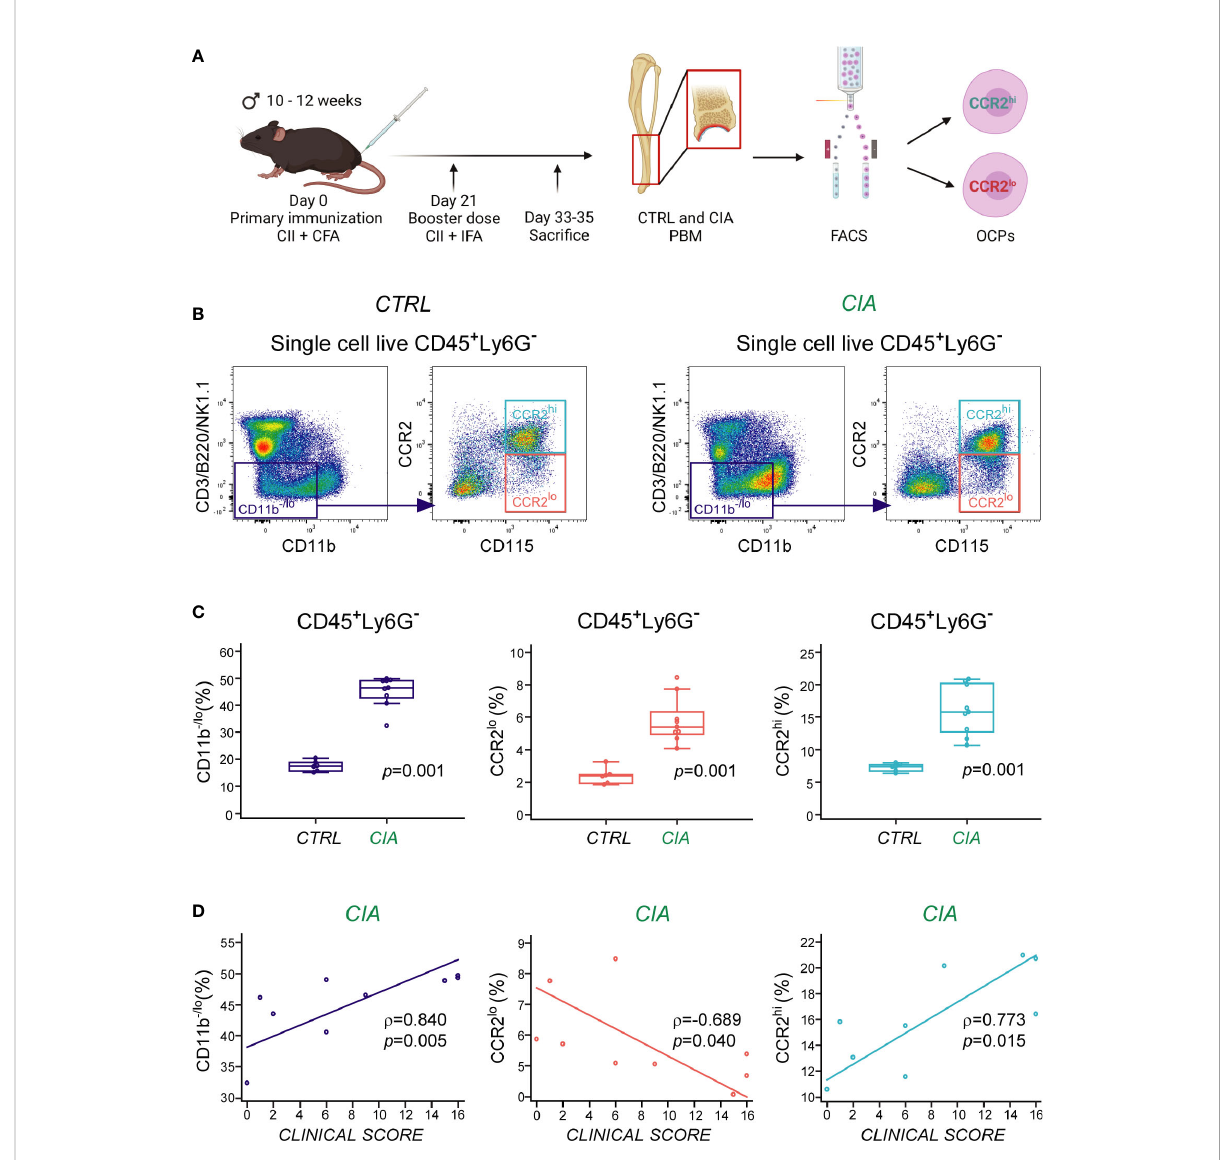
FIGURE 1 Increased frequency of CCR2 hi and CCR2 lo subsets of osteoclast progenitors (OCPs) in periarticular bone marrow (PBM) of mice with collagen- induced arthritis (CIA). (A) Experimental design of arthritis induction, with subsequent cell phenotyping and sorting by fl ow cytometry. CIA was induced in B6 mice, whereas the control (CTRL) group was left untreated. OCPs from PBM were identi fi ed as CD45 + Ly6G − CD3 − B220 − NK1.1 − CD11b – /lo CD115 + cells, and further separated based on the expression of chemokine receptor CCR2 (into CCR2 lo and CCR2 hi subsets). Created with BioRender.com (B) Representative dot-plots of CCR2 expression on OCPs from CTRL ( left ) and CIA ( right ) mice. OCPs were gated from non-lymphoid (CD3 − B220 − NK1.1 − ) cells with low expression of integrin CD11b (purple rectangle), and further separated to CD115 + OCPs with high expression of CCR2 (cyan rectangle) and low expression of CCR2 (red rectangle). (C) Frequency of non- lymphoid CD11b -/lo cells and CD115 + OCPs (CCR2 lo and CCR2 hi ) in CIA compared to CTRL mice (n=6-9). Individual values are presented; horizontal lines represent the median, boxes represent the interquartile range (IQR), and whiskers represent 1.5 times the IQR. Statistically signi fi cant difference was determined at p<0.05, Mann – Whitney U-test. (D) Association of the frequencies of CD11b -/lo cells and CD115 + OCPs (CCR2 lo and CCR2 hi ) with the clinical score of arthritis in CIA mice. Individual values and trend lines are presented with the Spearman ’ s rank correlation coef fi cient ( r ). Statistically signi fi cant difference was determined at